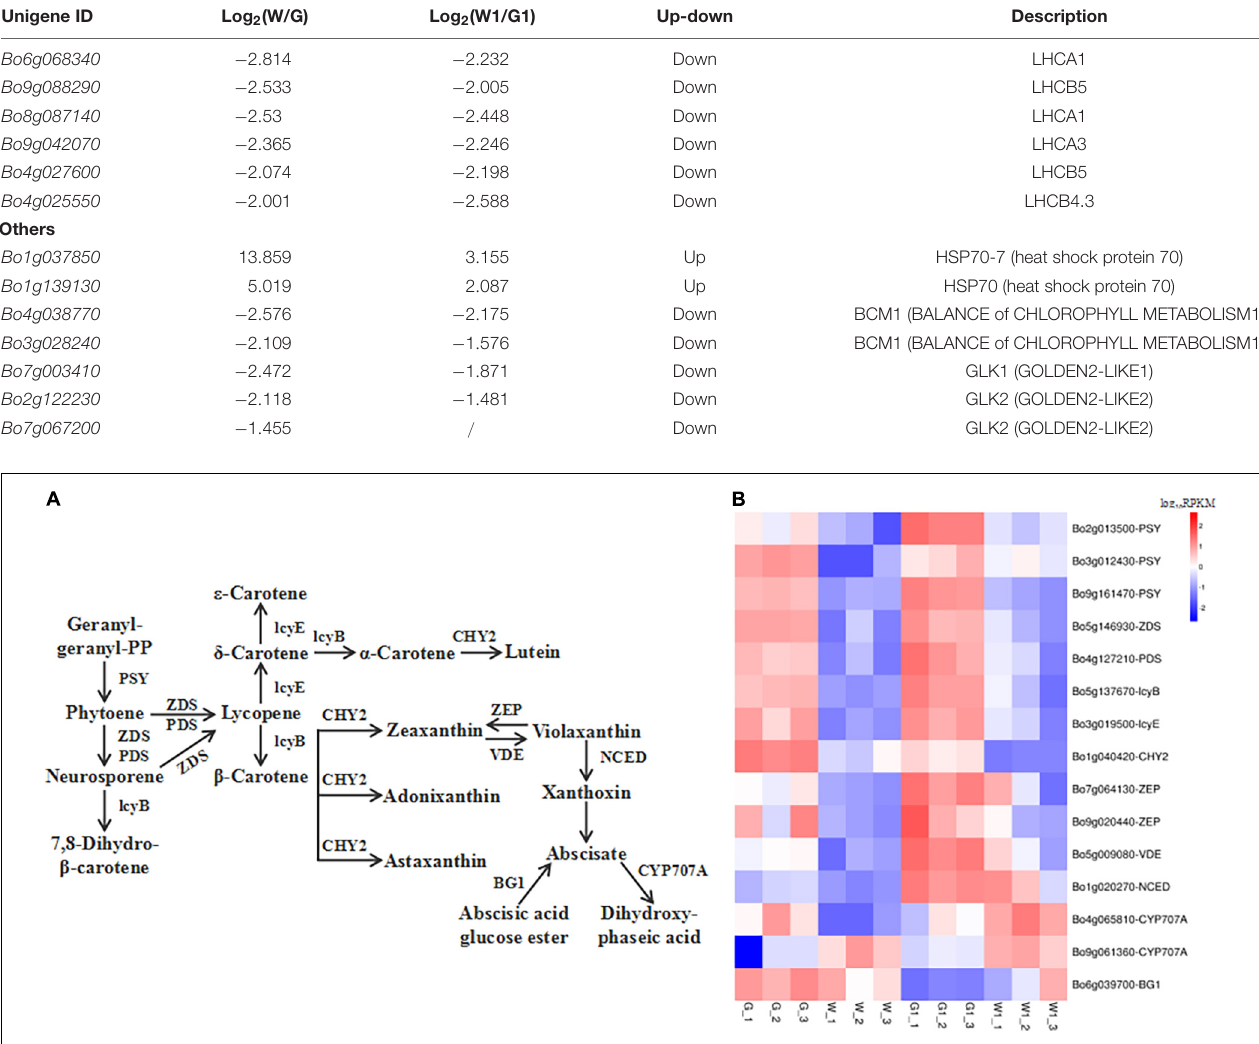
FIGURE 6 | Genes encoding enzymes involved in carotenoid metabolism are differentially expressed in green vs. white kale leaf tissues. (A) Diagrammatic representation of the carotenoid biosynthesis pathway involving the DEGs in G vs. W and G1 vs. W1. (B) Heatmap of the expression patterns of DEGs involved in carotenoid biosynthesis in the four samples. Red and blue tiles indicate higher or lower FPKM values,